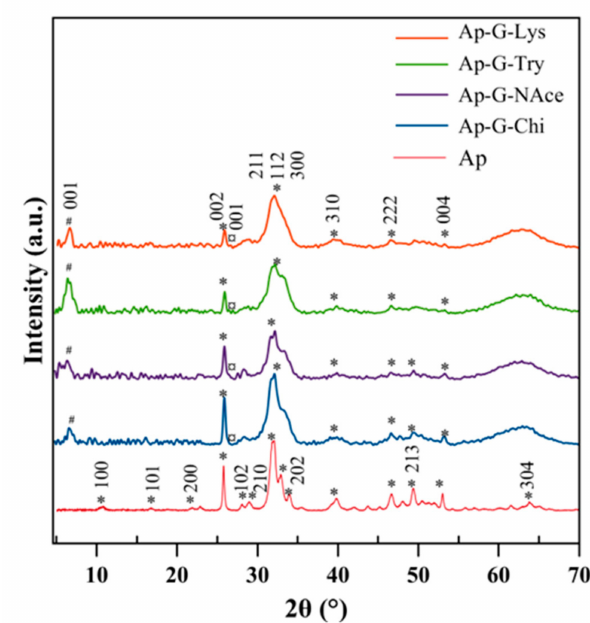
Figure 2. X-ray di ff raction (XRD) patterns of nanocrystalline apatite nucleated by the vapor di ff usion sitting drop (VDSD) method on graphene nanoflakes prepared by liquid-phase exfoliation (LPE) in the presence of Lys, Try, NAcel and Chi. (*) denotes apatite, (#) denotes the (001) plane of graphene, and (¤) denotes the (001) plane of residual